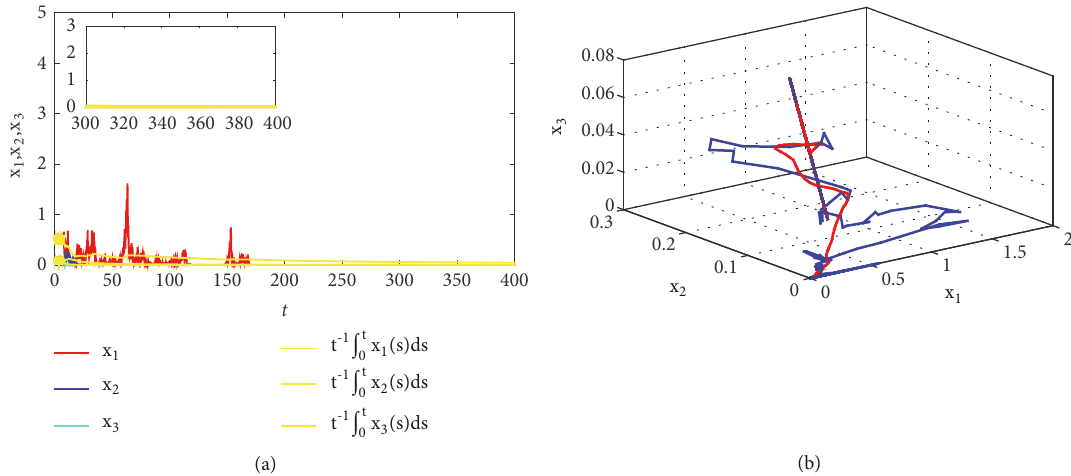
Figure 1: The extinction of three species is given in Theorem 11. (b) stands for the phase portrait of (a). The density of white noises is taken: 𝜎 = 7 , 𝜎 = 10 , 𝜎 = 6 1 2 3